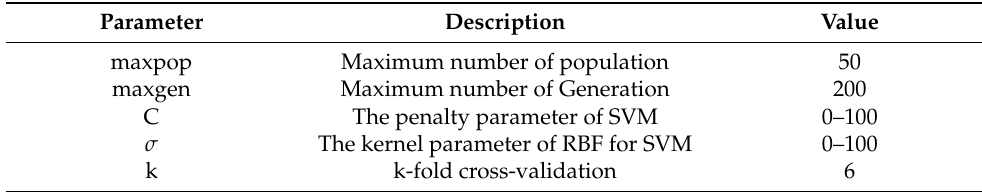
Table 4. Parameters used for the GA–SVM models.